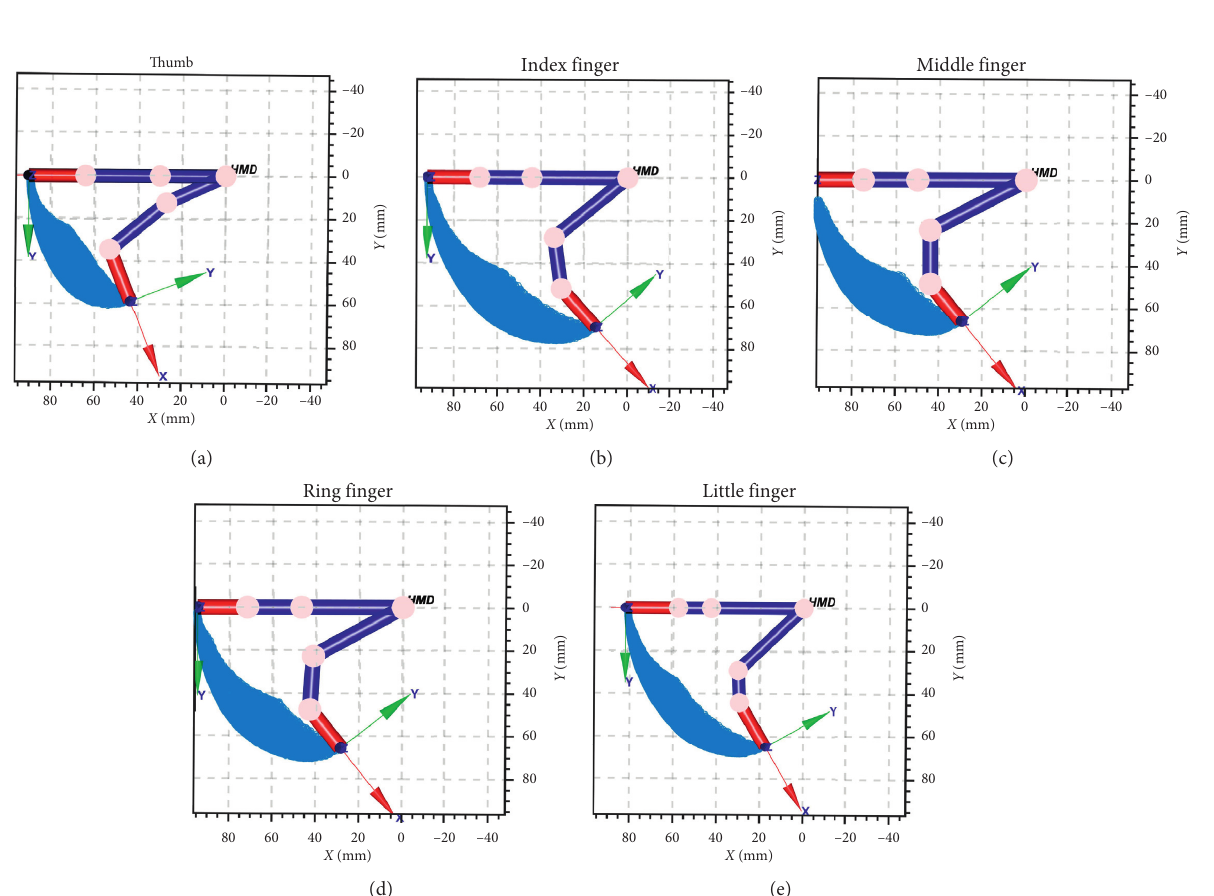
Figure 13: Visualization of the operating space of each finger. (a) Thumb. (b) Index finger. (c) Middle finger. (d) Ring finger. (e) Little finger.